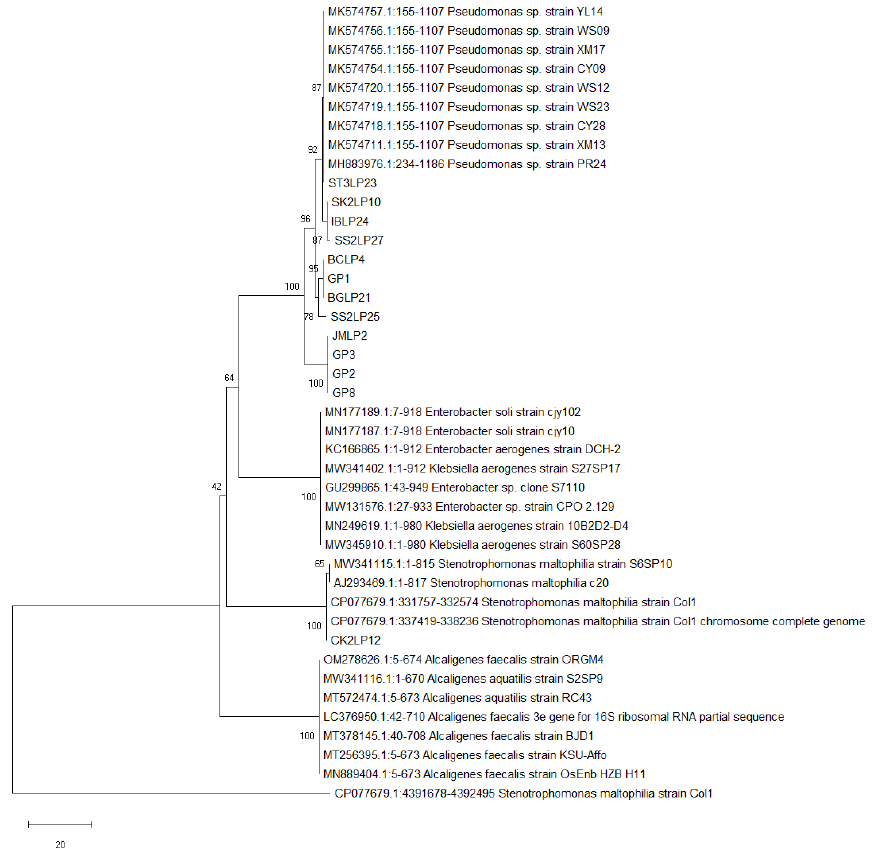
Figure 3. The phylogenetic tree of the 16S rDNA sequences of the Pseudomonad isolates collected from lateritic regions of West Bengal, India and selected reference sequences obtained from NCBI. The tree was constructed by using neighbour-joining method.